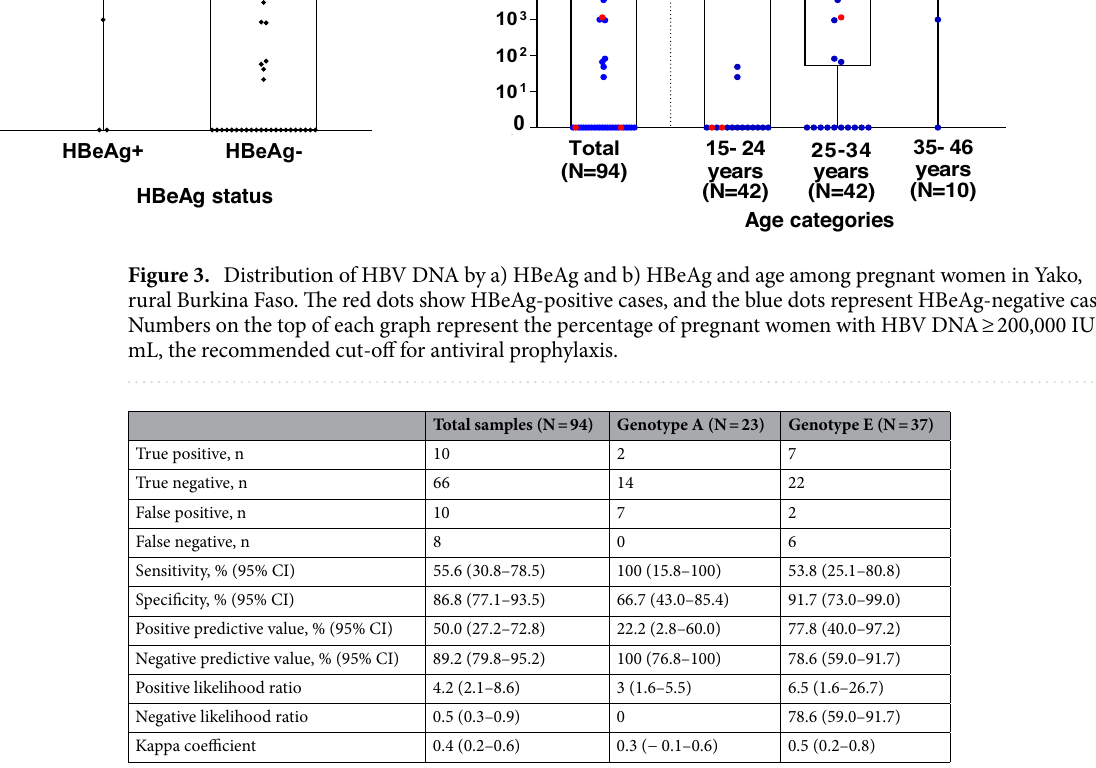
Table 2. Performance of HBeAg by using dried blood samples to detect HBV DNA ≥ 200,000 IU/mL. Viral load and HBeAg were available in 94 HBsAg-positive pregnant women. HBV genotype was successfully identified in 63 samples, of which 23 belonged to genotype A and 37 to genotype E. Genotype B and C represented 2 and 1 samples, respectively, and were not assessed for the accuracy of HBeAg to detect high viral